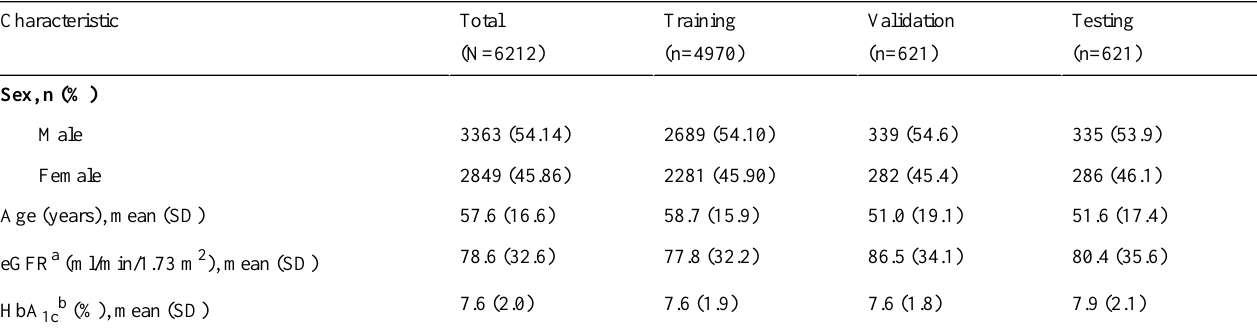
Table 1. Distribution of patients with clinical information in the training, validation, and testing groups.